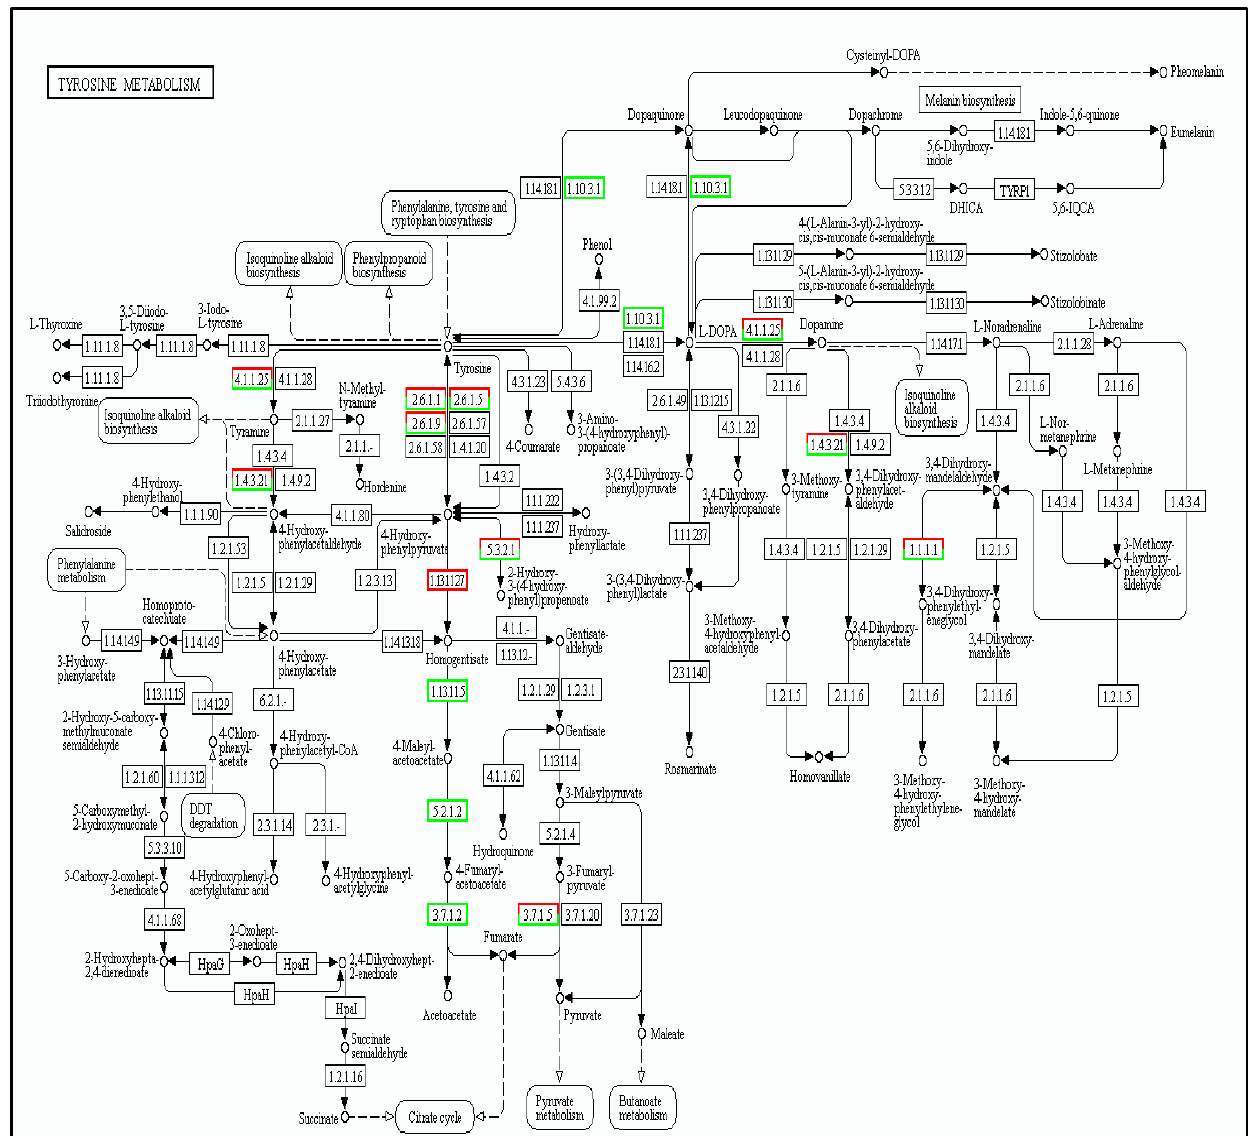
Figure 10. The cold tolerance genes of tea plants involved in Tyrosine metabolism pathways. Red boxes representing the upregulation of genes and green ones representing their downregulation.